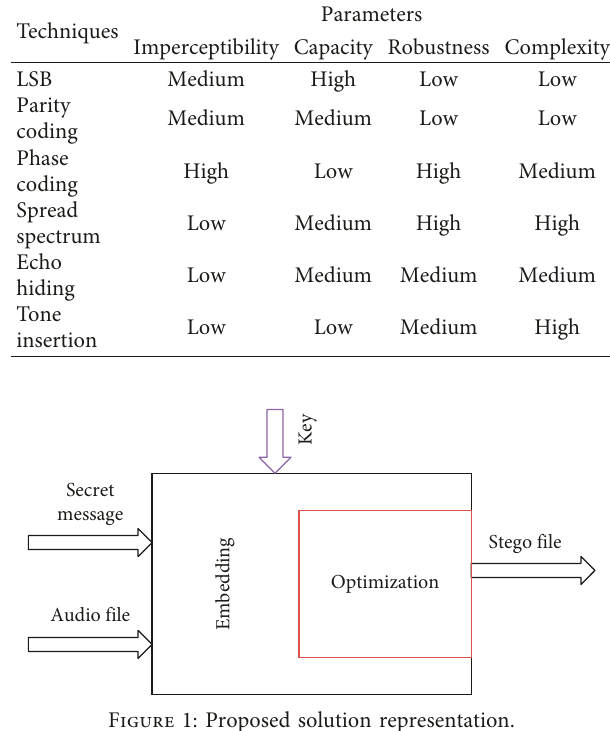
Table 1: Comparison of audio steganography techniques.